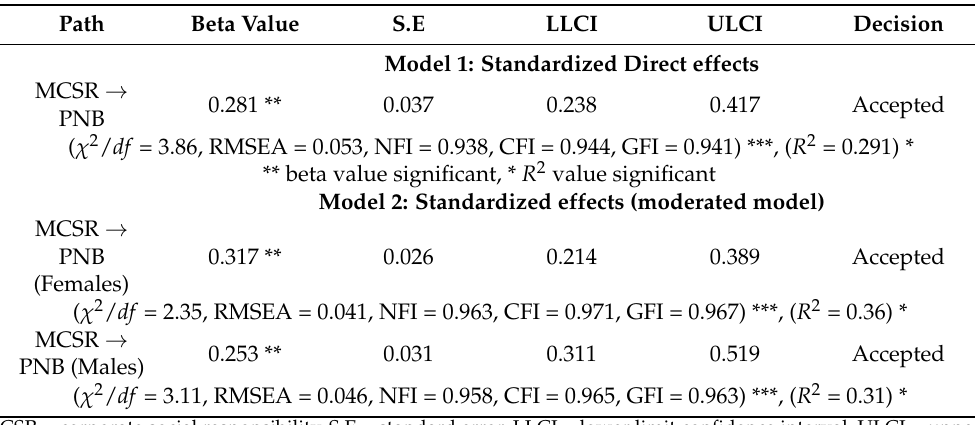
Table 4. Hypotheses